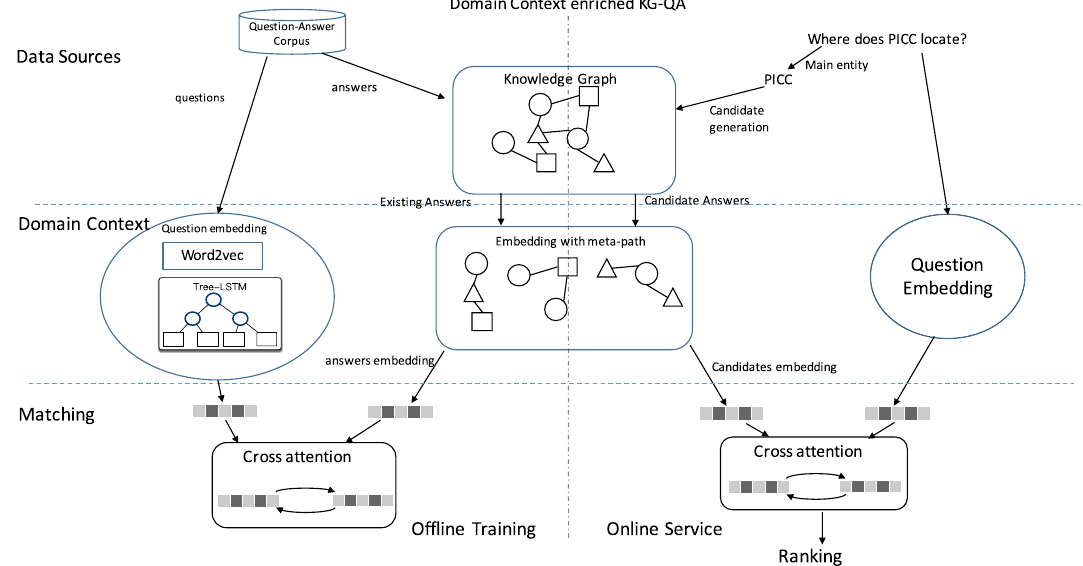
Fig. 2 Domain context for KG-QA